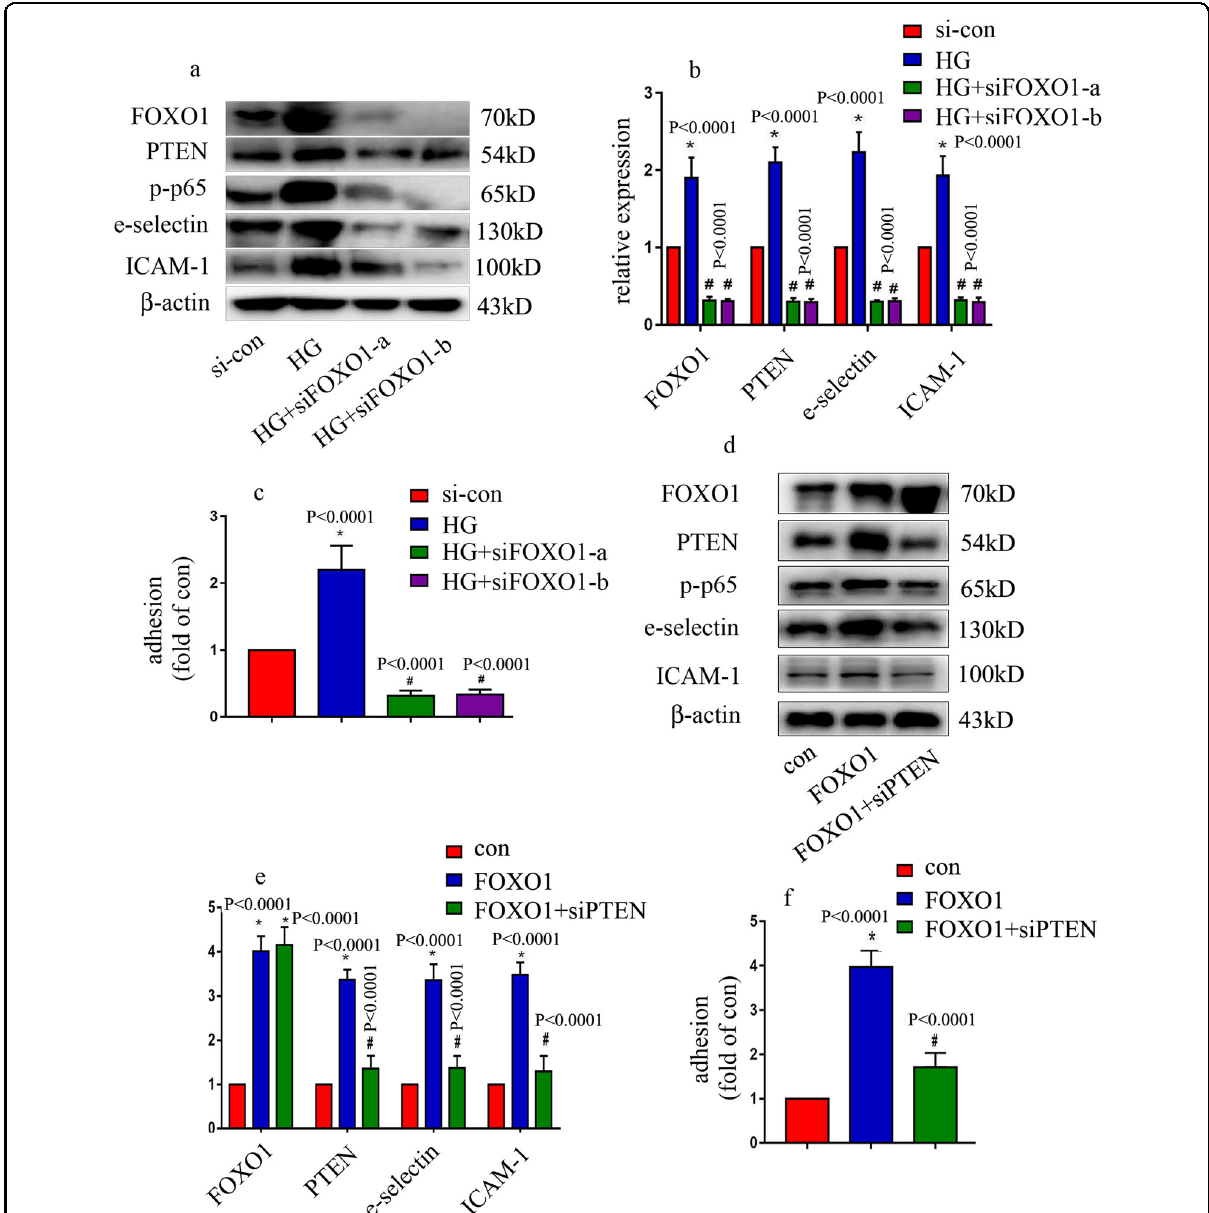
Fig. 5 FOXO1 downregulation reversed high glucose-mediated endothelial in fl ammation. a Results from the western blot analysis of PTEN, p- p65, e-selectin, and ICAM-1 expressions in HUVECs expressing siFOXO1 under high-glucose conditions. b Results from the qPCR analysis of PTEN, p- p65, e-selectin, and ICAM-1 expressions in HUVECs expressing siFOXO1 under high-glucose conditions. c The effects of siFOXO1 on high glucose- induced monocyte/endothelial adhesion were measured. d Results from the western blot analysis of PTEN, p-p65, e-selectin, and ICAM-1 expressions in HUVECs with siPTEN under FOXO1 overexpression conditions. e Results from the qPCR analysis of PTEN, p-p65, e-selectin, and ICAM-1 expressions in HUVECs with siPTEN and overexpressing FOXO1. f The effects of siPTEN on FOXO1 overexpression-induced monocyte/endothelial adhesion were measured. * P < 0.05, compared with the control group; # P < 0.05, compared with the high-glucose treatment group, n =